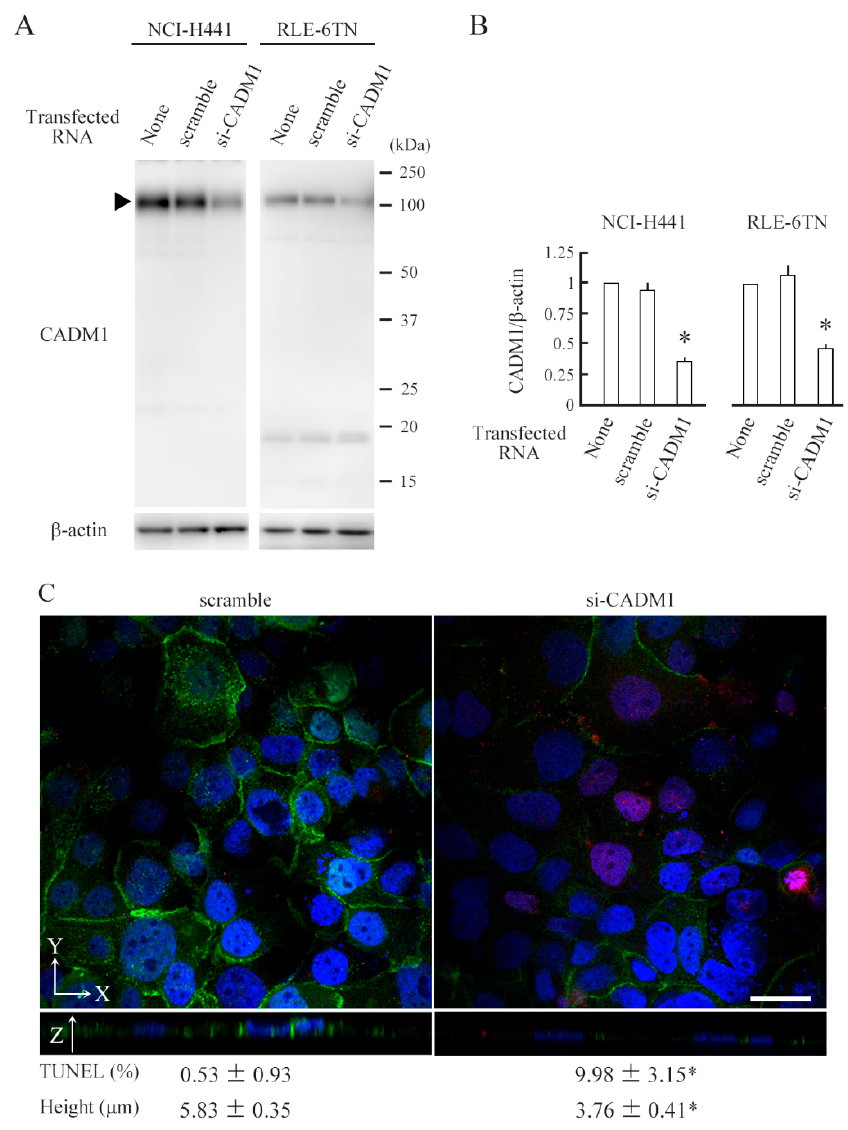
Figure 3. CADM1 downregulation flattens NCI-H441 epithelial cells and induces apoptosis. NCI-H441 and RLE-6TN cells were cultured on a semipermeable membrane in 12-well plates. When the cells reached 100% confluence, they were transfected with scramble RNA or CADM1 -targeting siRNA (si-CADM1), or without RNA, by electroporation. After 2 days, the cell lysates were extracted, and were blotted with the antibodies indicated ( A ). Intensities of the immunoreactive bands for CADM1 (the full-length form depicted by an arrowhead) and β -actin were measured densitometrically. The mean ratios of CADM1 to β -actin and their standard deviations were calculated from the data obtained in triplicate experiments. Statistical di ff erences were analyzed by one-way ANOVA (see Supplementary Table S2). * p < 0.001 by Bonferroni correction when compared with scramble RNA transfection. ( B ). After 2 days of transfection, NCI-H441 cells were triple-stained with CADM1 immunofluorescence (3E1 antibody; green), TUNEL method (red), and DAPI nuclear staining (blue). The means and standard deviations of TUNEL-positive cell proportions and cell heights were calculated from the data obtained in triplicate experiments ( C ). * p < 0.01 by Student’s t -test when compared with scramble RNA transfection. Scale bar = 10 µm.